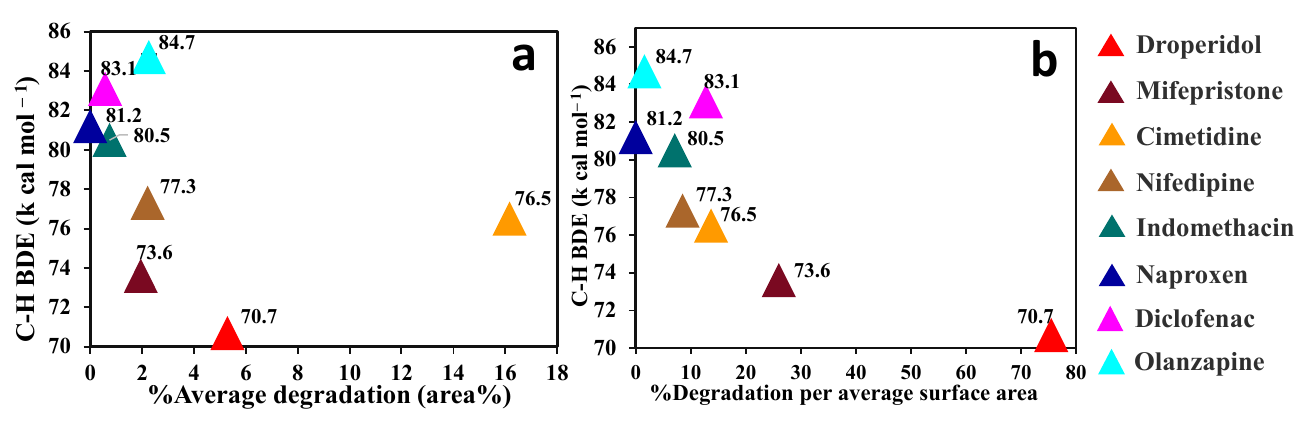
Figure 3. Comparison of C–H BDE versus solid-state degradation of selected compounds without ( a ) and with surface area normalization ( b ). The numbers next to the symbols are the calculated C–H BDE of the respective compounds.